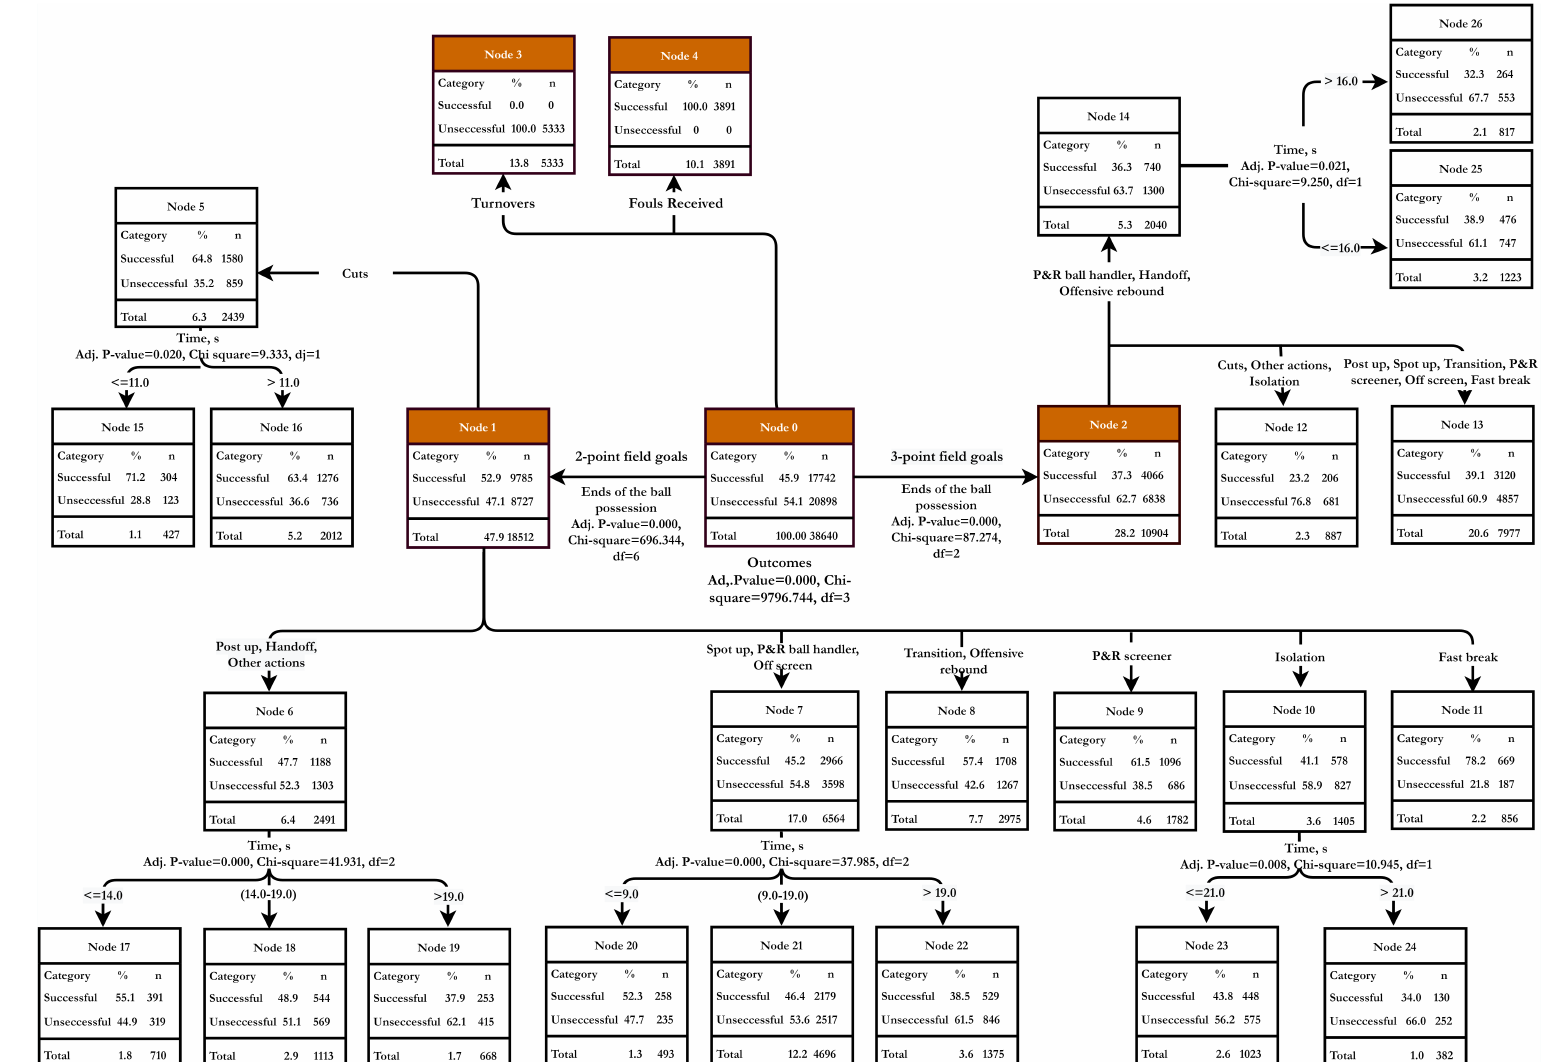
Figure 1. Chi-square Automatic Interaction Detector (CHAID) tree describing frequency effectiveness (%) of the predictive model of successful ends of the ball